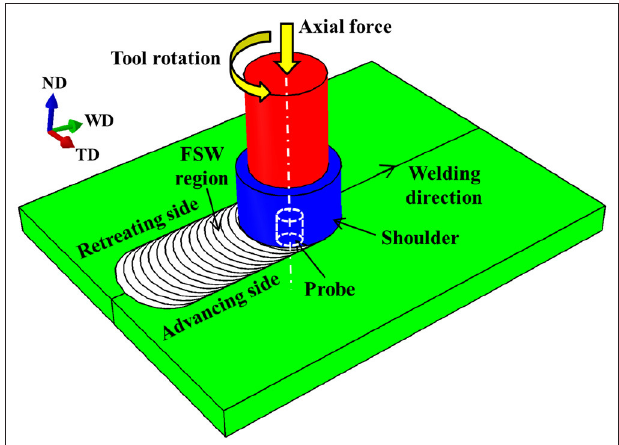
FIGURE 1 | Schematic illustration of the FSW process.